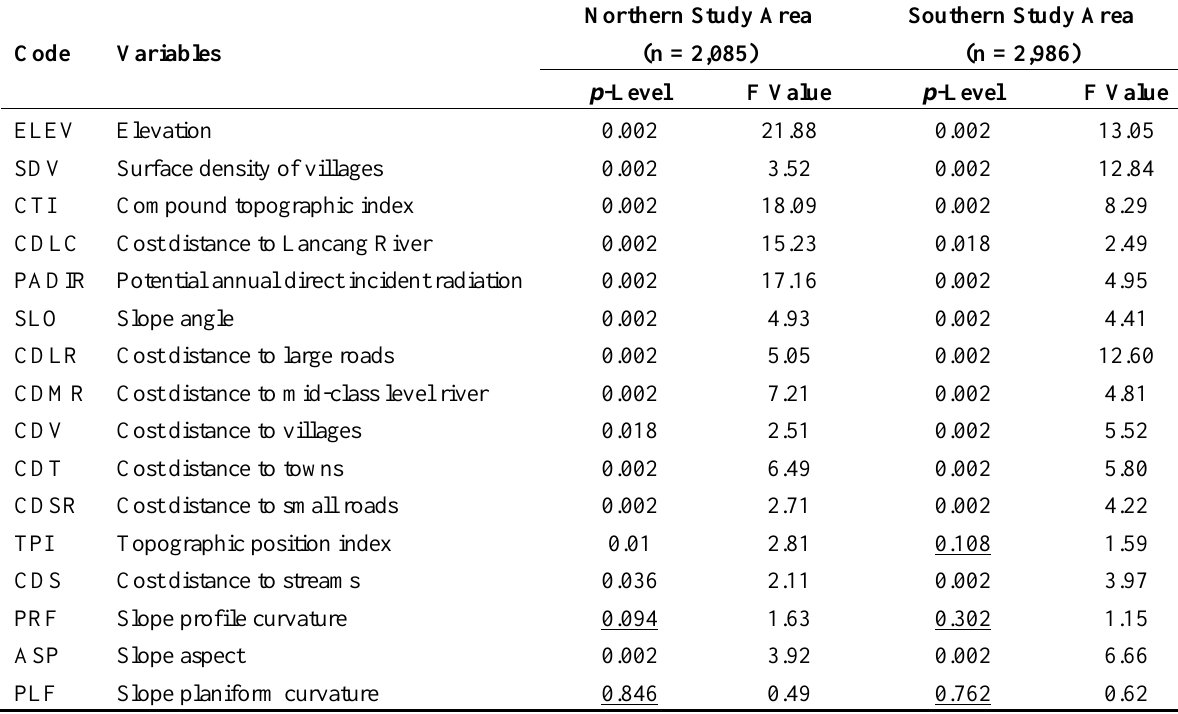
Table 8. Statistical significance of topography and human disturbance variables for vegetation spatial patterns in the two study